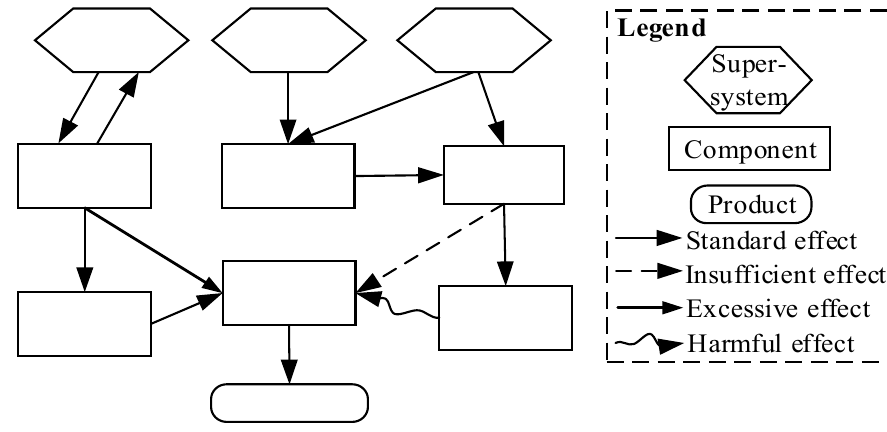
Figure 3. Elements of the TRIZ function model—fill contents in the chart.